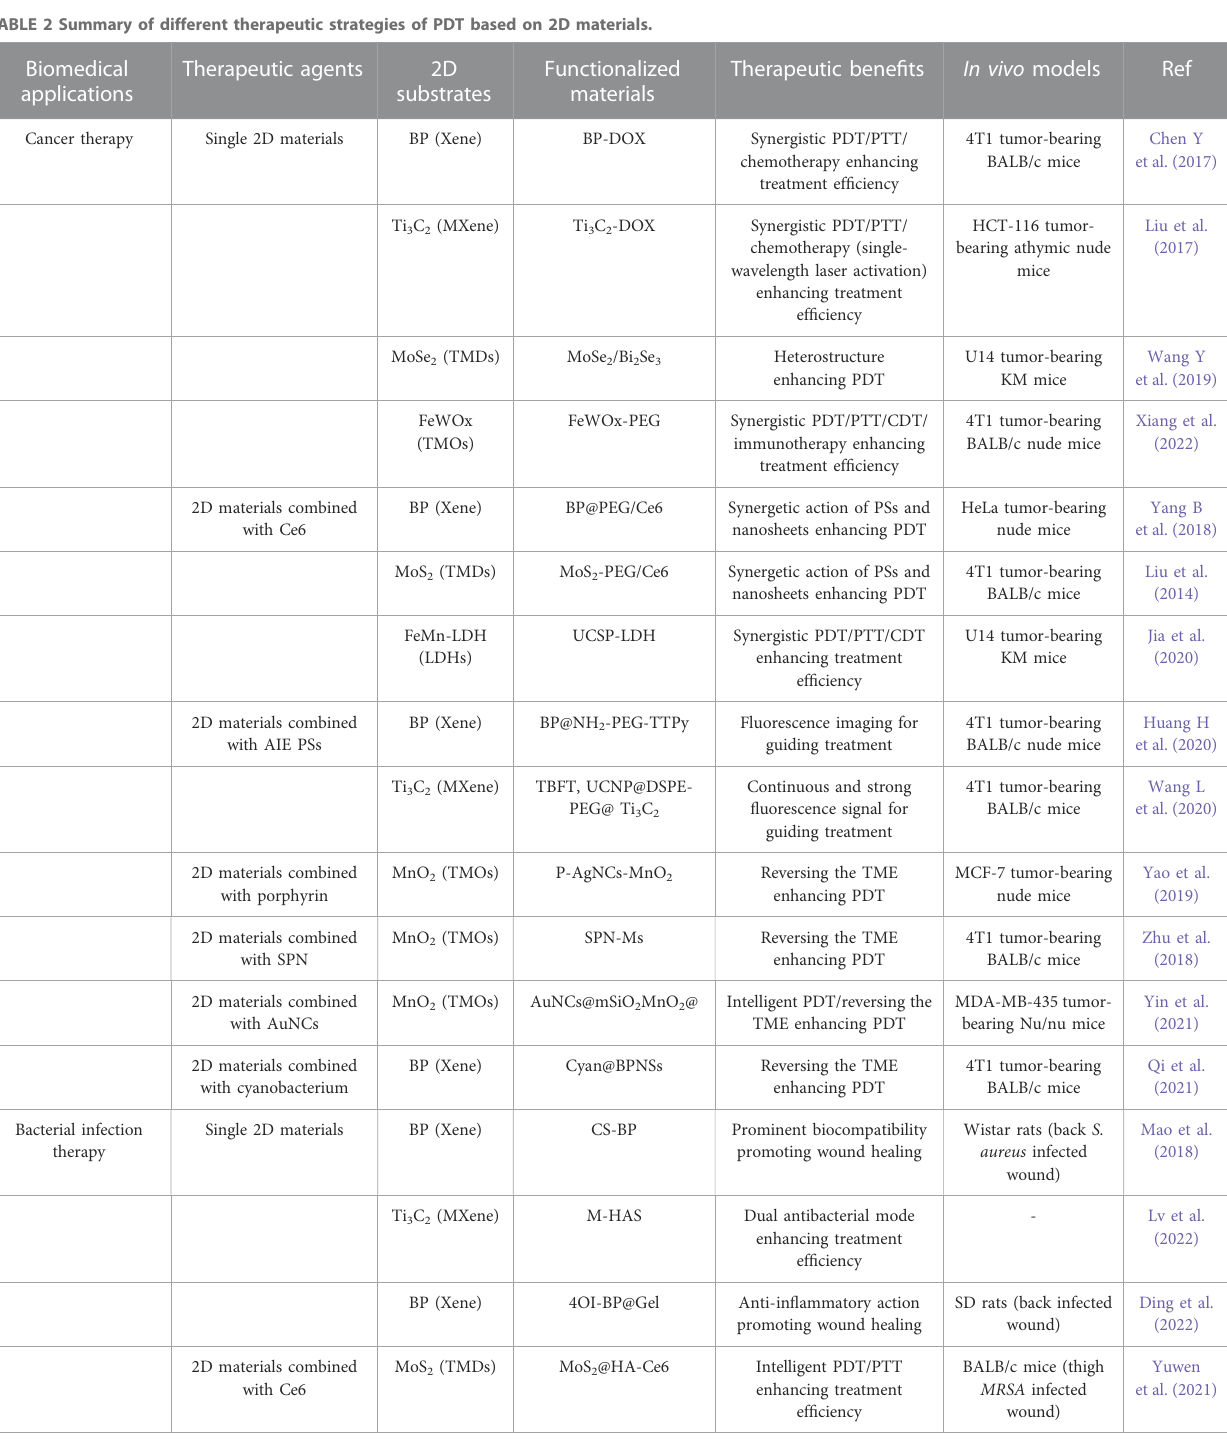
TABLE 2 Summary of different therapeutic strategies of PDT based on 2D materials. Biomedical